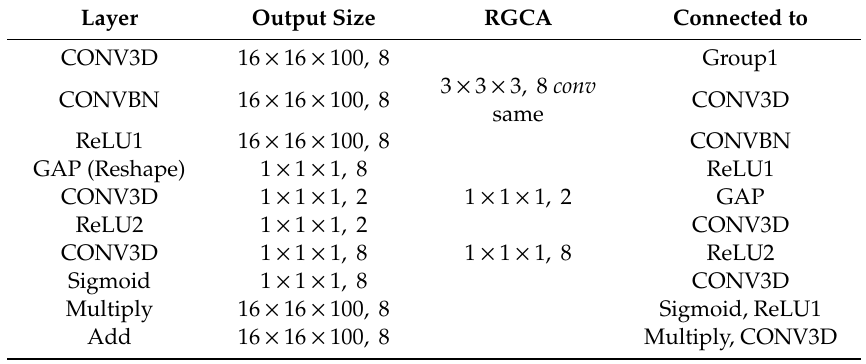
Table 2. The network configuration of the residual group channel-wise attention (RGCA) module.